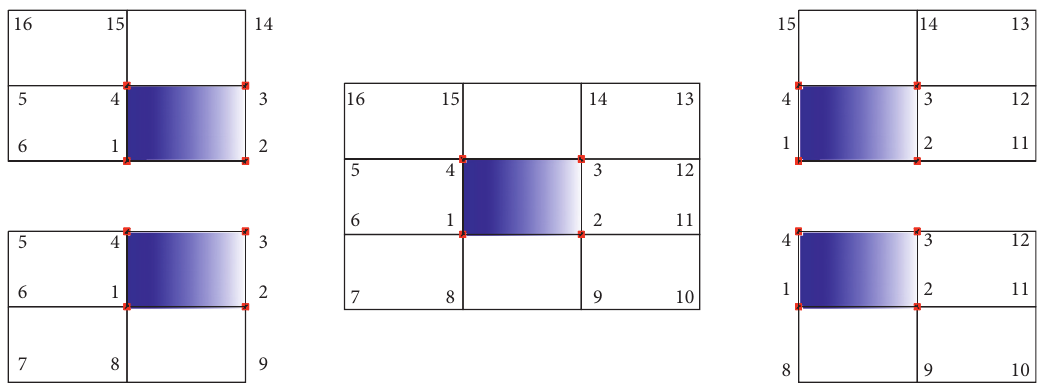
Figure 3: A manifold element and its “physical stars”.